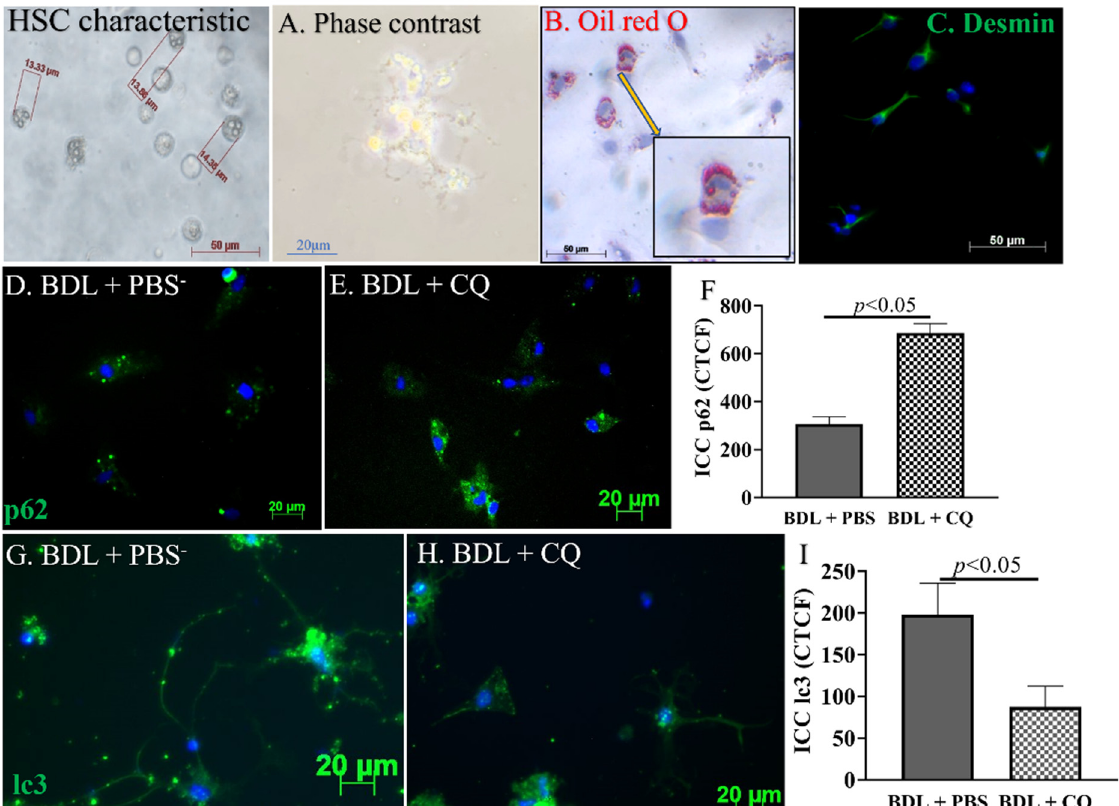
Figure 4. Effects of CQ on HSCs in vivo autophagy. ( A – C ) Representative images of the phenotypic characteristics of HSCs isolated from Sham mice: phase contrast images of cells 24 h after seeding ( A ), Oil red O staining (B), and desmin staining (C; green, desmin staining; blue, nucleus staining). ( D – F ) Representative images of the sqstm1/p62 staining in isolated HSCs and graph comparison of CTCF (Correct Total Cell Fluorescence quantification) from ICC staining. ( G – I ) Representative images of the lc-3b staining in isolated HSC and graph comparison of CTCF from ICC staining in BDL + PBS and BDL + CQ mice, n = 3.